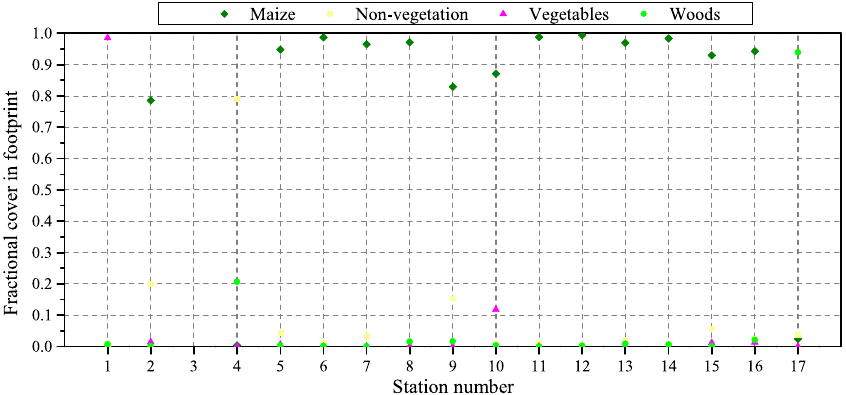
Figure 5. The fractional weight of each land-cover class in the daytime-averaged flux footprint of each EC flux measurement for 29– 30 June